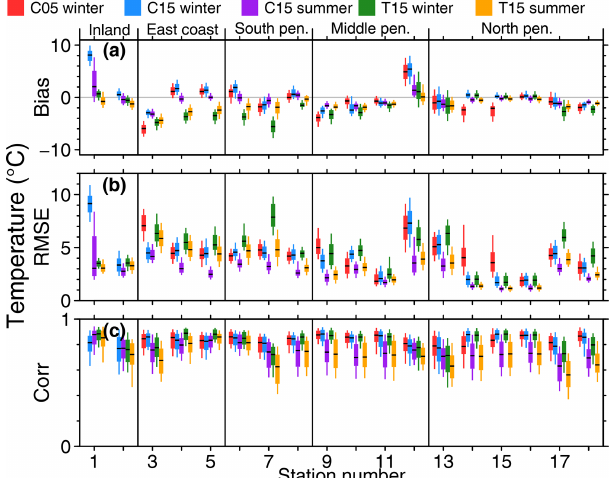
Figure 9. As Fig. 7 but for 10m wind